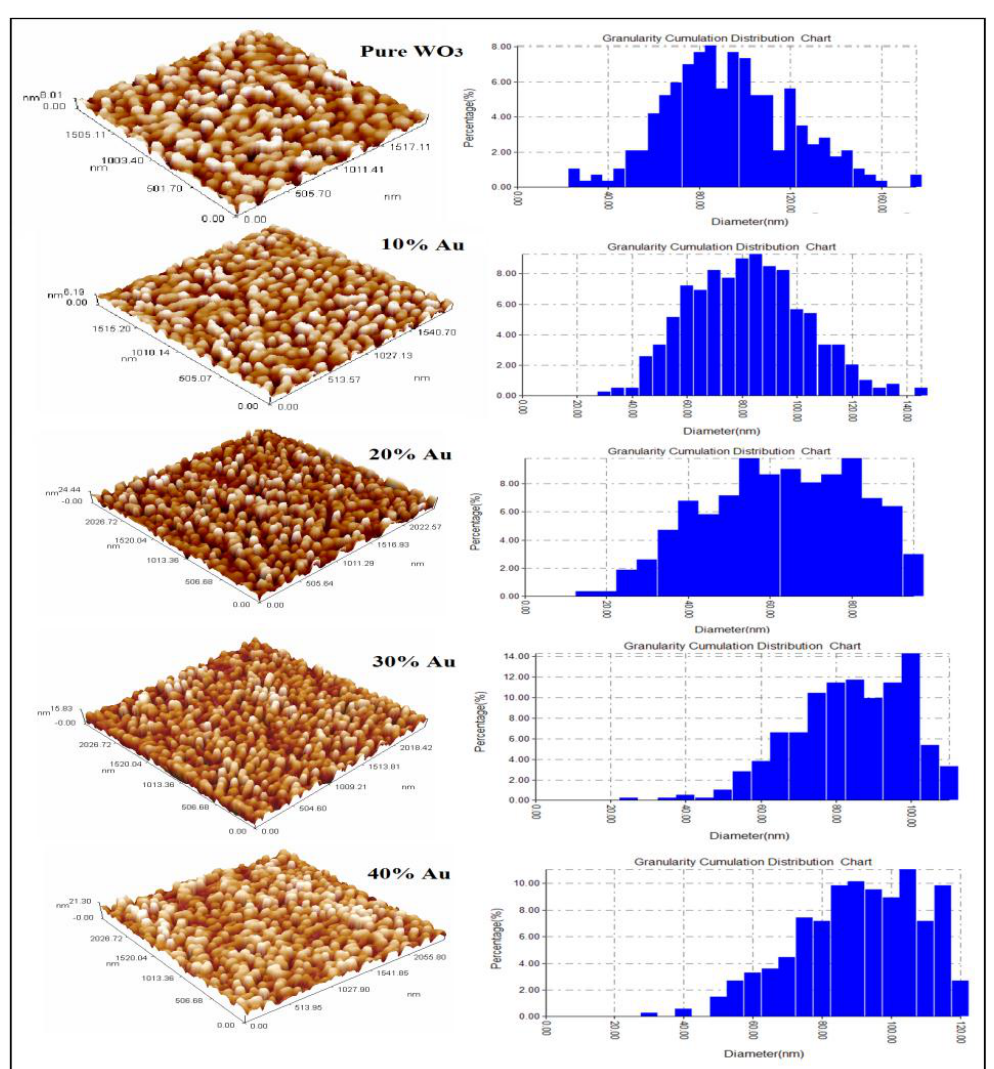
Fig. 3: AFM image and size distribution for pure WO and doping with different ratio of 3 Au thin films at room temperature 250